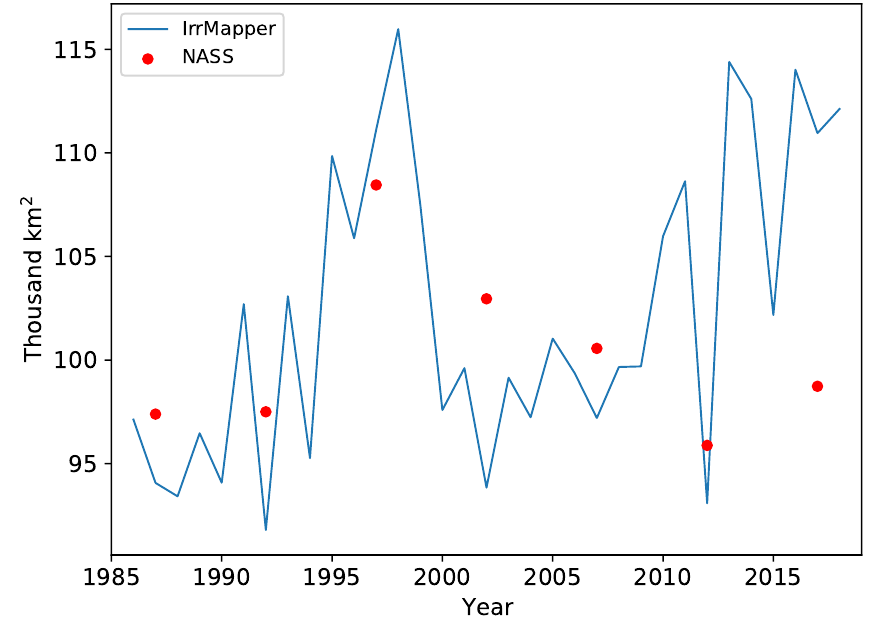
Figure 9. Comparison of NASS Census of Agriculture and IrrMapper estimates of irrigated area over the study domain. IrrMapper roughly follows the same pattern in irrigated area as the semi-decadal NASS estimates of total irrigated